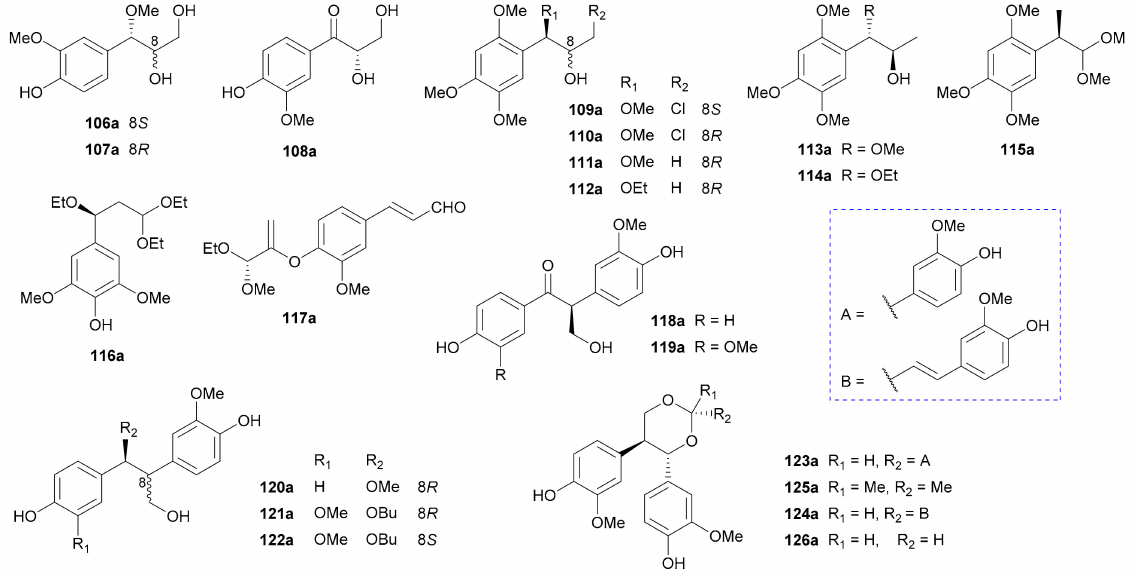
Figure 7. Structures of simple